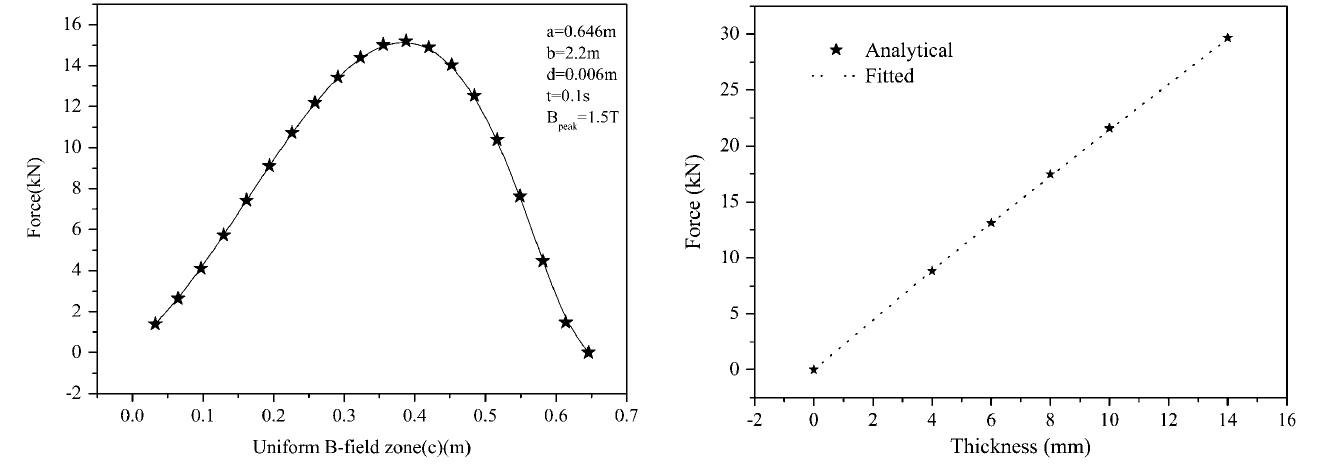
FIG. 14. The variation of the force on the chamber due to the eddy current when exposed to a nonuniform time varying magnetic field for various uniform field zones ( c ) keeping the length and width of the plate constant as 2.2 and 0.646 m, respectively.